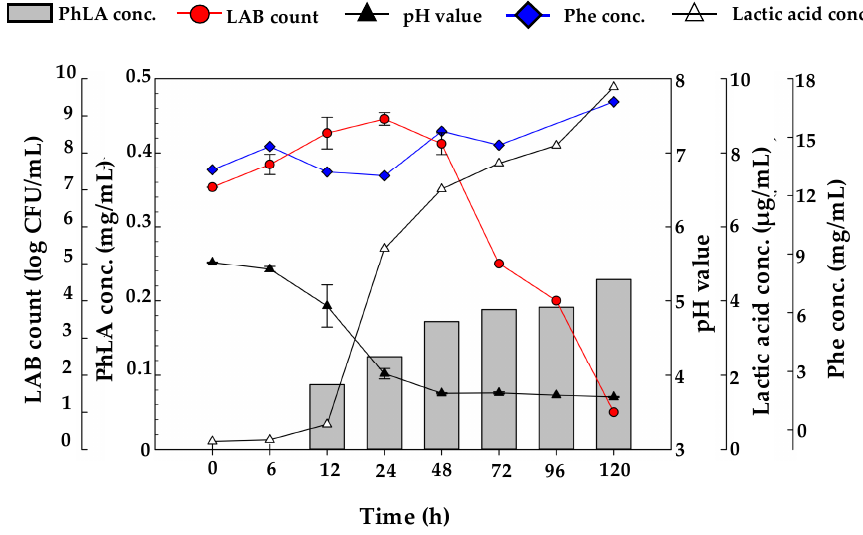
Figure 7. After pretreatment of Porphyra residues by commercial cellulase (2000 U), the LAB count, pH value, and concentration of PhLA, lactic acid and Phe in 8% Porphyra residues with the addition of Phe (1.36%) and yeast extract (0.5%) and fermented with KP3 at 37 °C for 0 to 120 h.